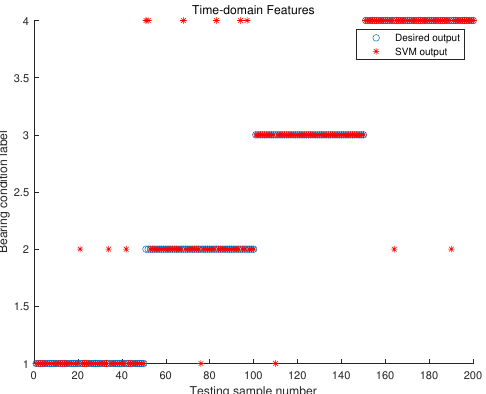
Figure 12. Recognition results of SVM classifier based on time-domain features.